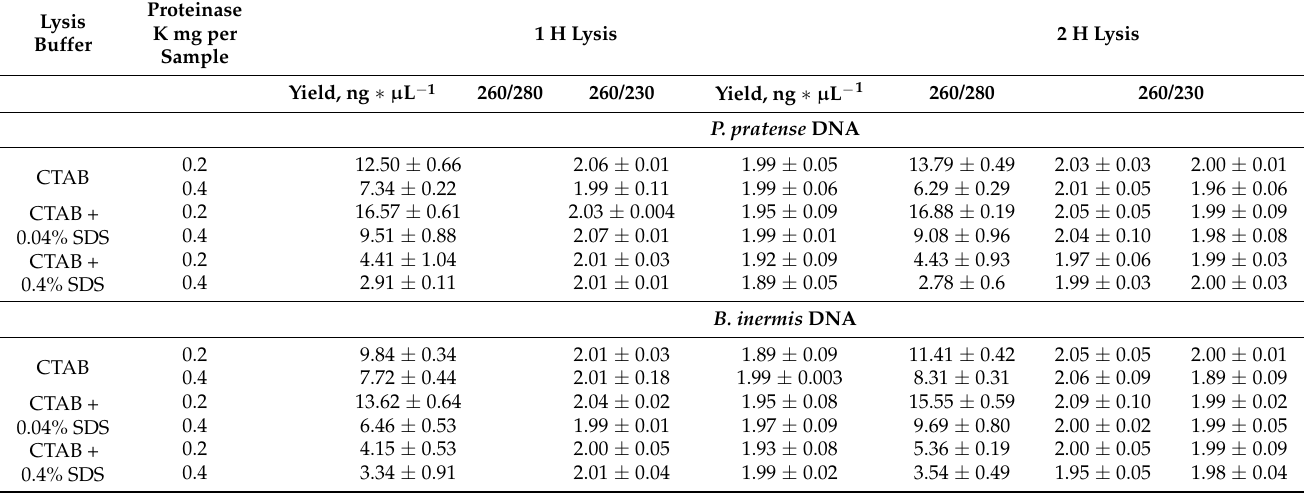
Table 3. Pollen DNA extraction lysis-buffer optimization results.